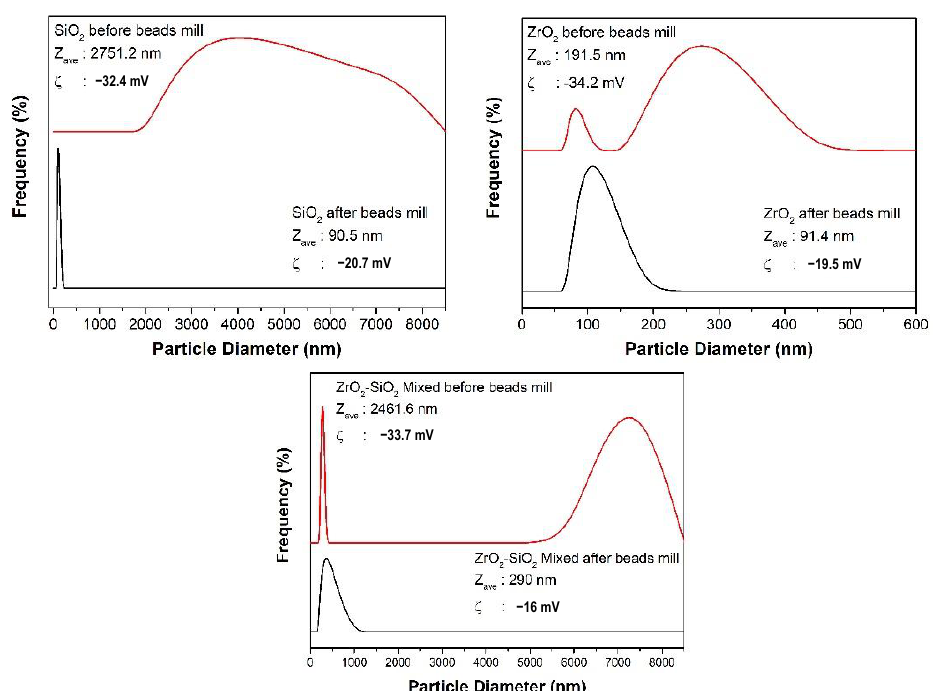
Figure 3. Particle size and stability of SiO 2 , ZrO 2, and ZrO 2 -SiO 2 mixed filler solutions.